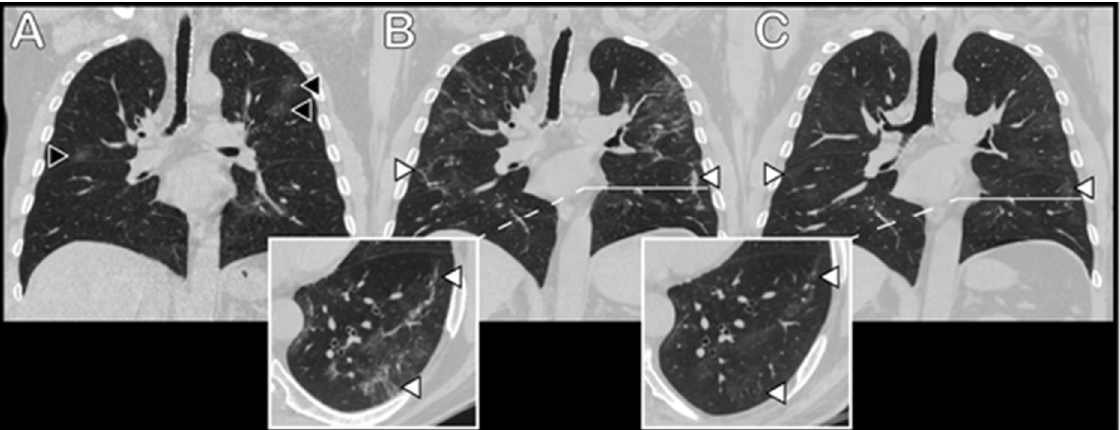
Figure 1. Coronal reconstructions and axial thin-section chest CT images of a 70-year-old man with confirmed COVID-19 pneumonia. ( A ) First CT scan 4 days after the onset of symptoms in the early stage of disease. Mild randomly distributed ground-glass opacities (black arrowheads) can be seen in both lungs. ( B ) CT scan at a later stage of disease (27 days after the onset of symptoms). Progression of previously observed ground-glass areas, as well as new areas of opacification can be seen. A reticular pattern emerged, with some parenchymal bands in peripheral parts of the lungs. ( C ) Follow-up CT scan 2 months later. A decrease in the density of ground-glass opacities can be seen, with only a slight decrease in the area of lesions. Some parenchymal bands persisted, with a decrease in abundance and thickness (white arrowheads).